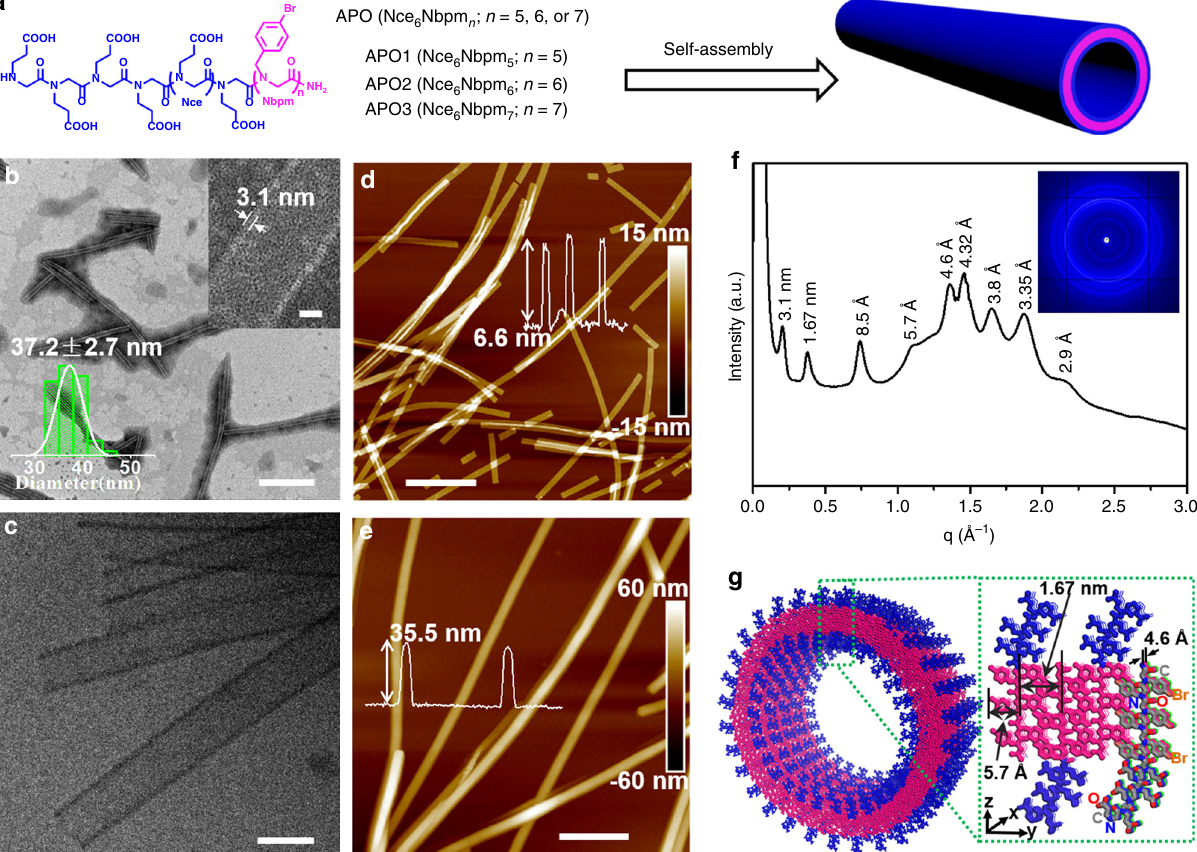
Fig. 1 APOs assembled into highly-ordered SW-PNTs. a APOs structures and the scheme showing the assembly of APOs into SW-PNTs. b TEM image of PNTs assembled from APO2 (scale bar, 500 nm); top right corner inset is the high-resolution TEM image showing the PNT wall thickness (scale bar, 10 nm); lower left corner inset is the statistical size distribution of PNT diameter (37.2 ± 2.7 nm) obtained by analyzing 50 PNTs. c Cryo-TEM image of APO2- PNTs (scale bar, 50 nm). d Ex situ AFM height image of APO2-PNTs showing their thickness of 6.6 nm under dry condition (scale bar, 600 nm). e In situ AFM height image of APO2-PNTs showing the thickness of 35.5 nm in water (scale bar, 500 nm). f XRD spectrum of APO2-PNTs. The values above each peak is calculated according to the formula of d = 2 π / q . g A proposed model showing the molecular packing of APO2 within PNTs, in which the peptoid backbone to backbone distance is 4.6 Å along the x direction and is 1.67 nm along the y direction; APO hydrophobic domains were highlighted in pink and the polar domains were in blue; one APO2 molecule was highlighted with elements in various colors (nitrogen, blue; oxygen, red; carbon, gray; bromide,